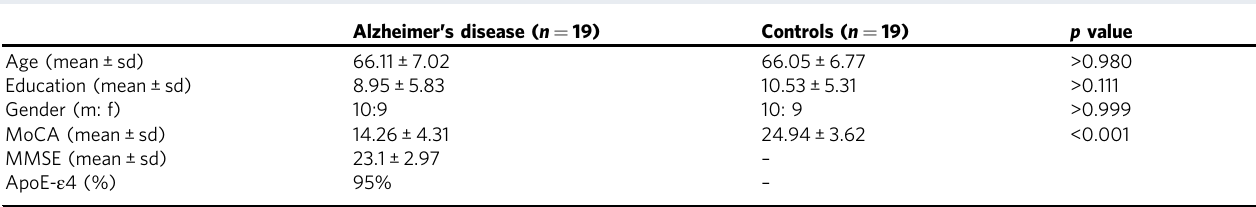
Table 1 Demographics and brief clinical